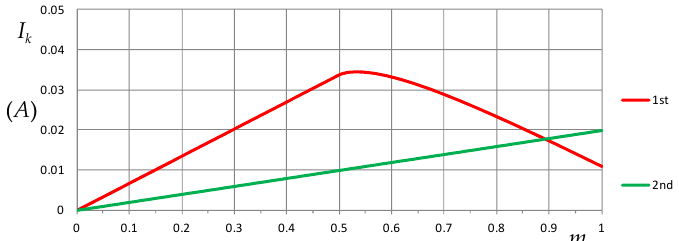
Figure 8. Amplitude of dominating low-frequency PV current harmonics as a function of the modulation index in the case C H = 1 mH, I ac = 1 A, and R PV = 40 Ω . modulation index in the case C H = 1 mH, I ac = 1 A, and R PV = 40 Ω .